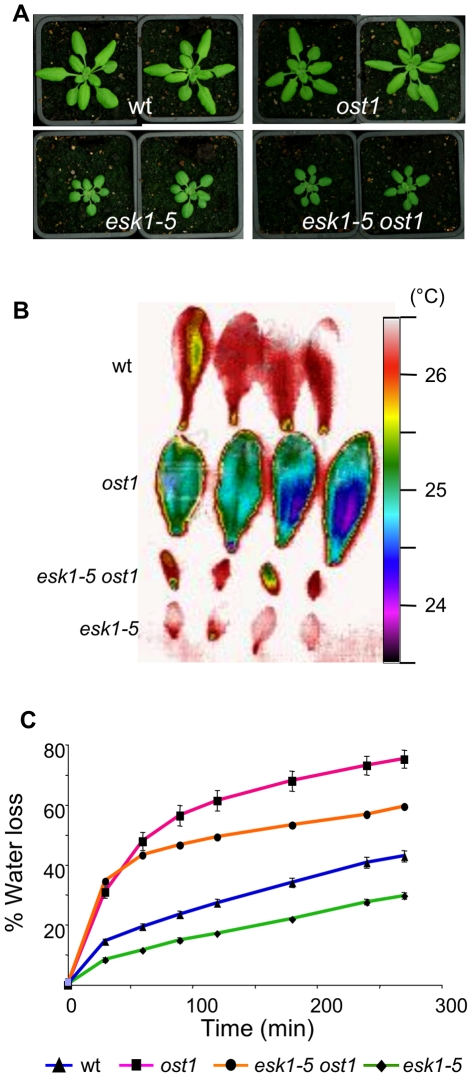

esk1-5 ost1 double mutant phenotypes.A. Two representative plants of each genotype grown in standard non-stressed conditions: wild type (wt), ost1, esk1-5 and esk1-5 ost1 double mutant. B. False color infrared image of detached leaves from 4 week-old plants, 2 leaves from 2 plants were observed for each genotype. C. Rapid dehydration of detached rosettes from 4 week-old plants. Water loss was determined as % of initial fresh weight. Error bars represent standard error values (n = 4).